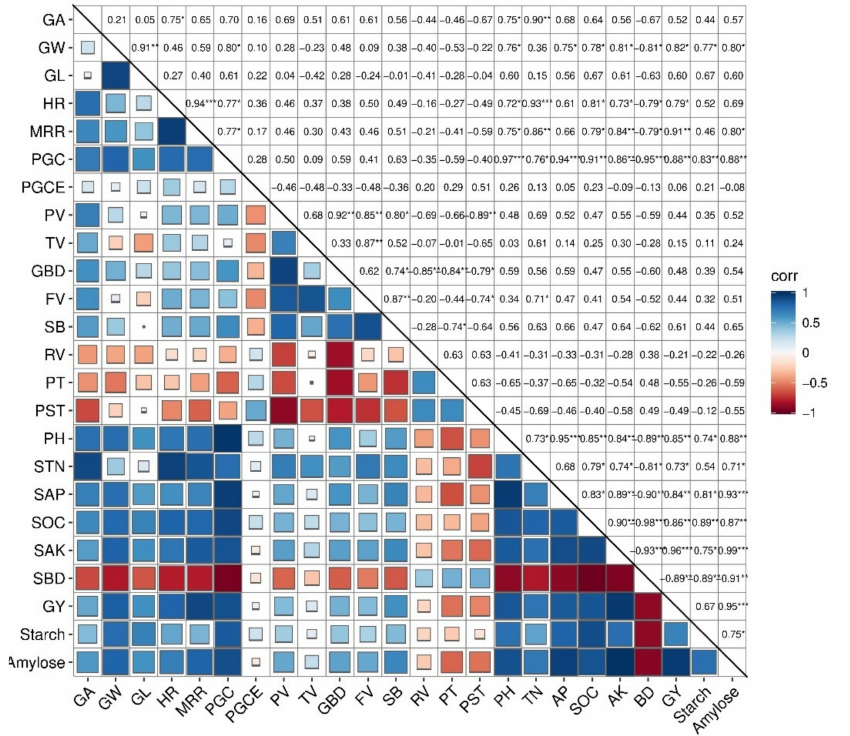
Figure 5. Correlations heat map of soil properties, grain appearance quality, milling quality, and RVA profile of rice using R software. Square with red to dark blue color indicates the relationship from negative to positive. Square size from small to big indicates the moderate positive/negative to strongly negative/positive relationship. The values in the figure showed the R-squared